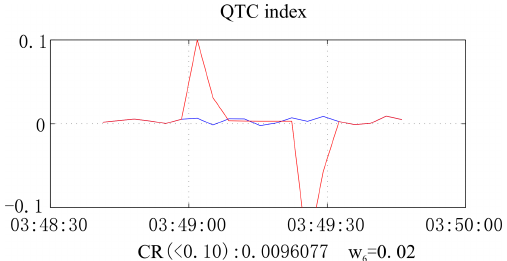
Figure 7. QTC index of original data (blue) and simulated data of amplitude variation